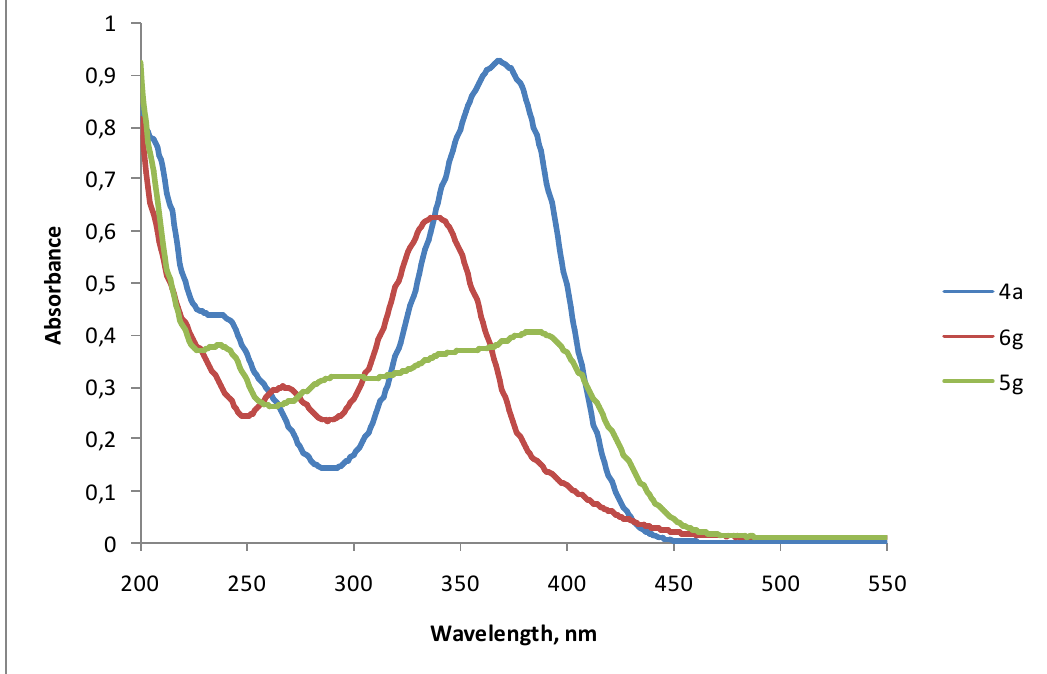
Figure 7. UV–Vis spectra of compounds 4a , b , i , k in MeCN (2 × 10 − 5 M).